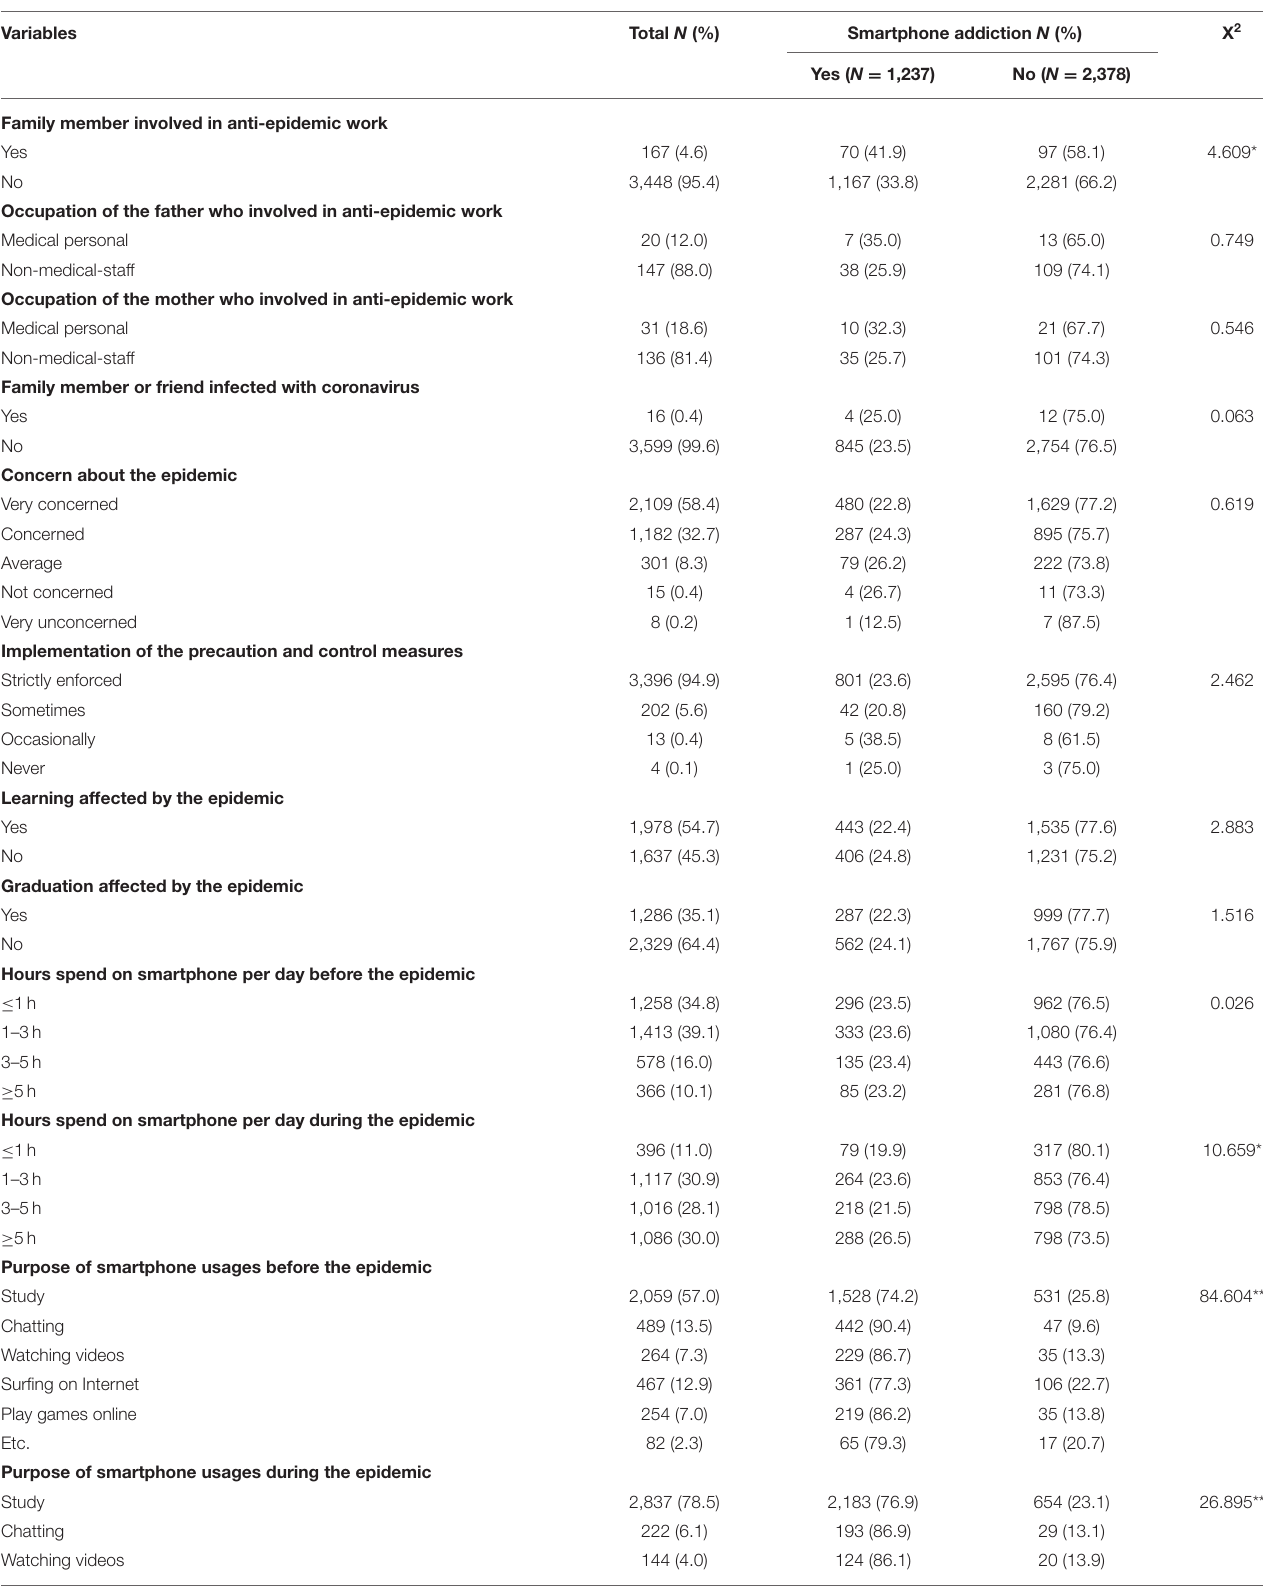
TABLE 2 | The impact of reported COVID-19 related information and clinical depressive symptoms on smartphone addiction ( N = 3,615).